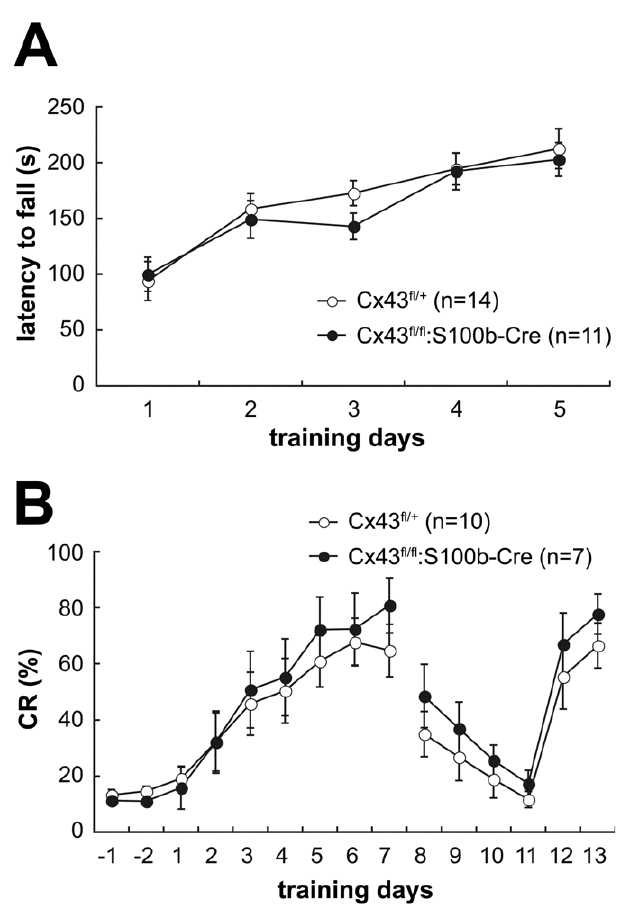
Figure 10. Behavioral analysis of control ( Cx43 fl / + ) and Cx43 fl /fl :S100b- Cre mice. (A) Accelerating rotarod test. The mean ( ± SEM) time an animal remained on an accelerating rod (6–40 rpm) during training with 1 trial per day for 5 consecutive days. (B) Delay eyeblink conditioning. The mean ( ± SEM) CR percentage of Cx43 fl / + ( n = 10) and Cx43 fl /fl :S100b-Cre ( n = 7) during acquisition (days 1–7), extinction (days 8–11), and relearning (days 12–13)